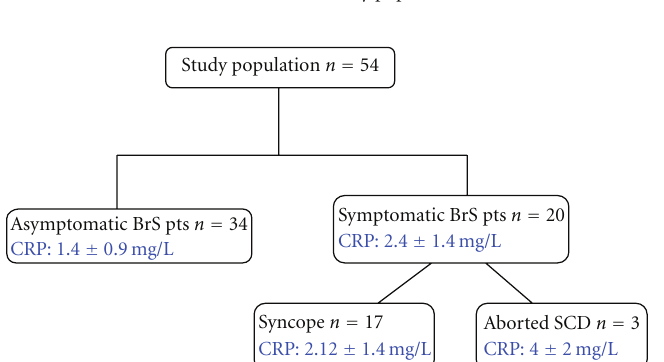
Figure 1: Fifty-four patients with BrS were divided into two groups according to the clinical feature. BrS: Brugada syndrome; CRP: C-reactive